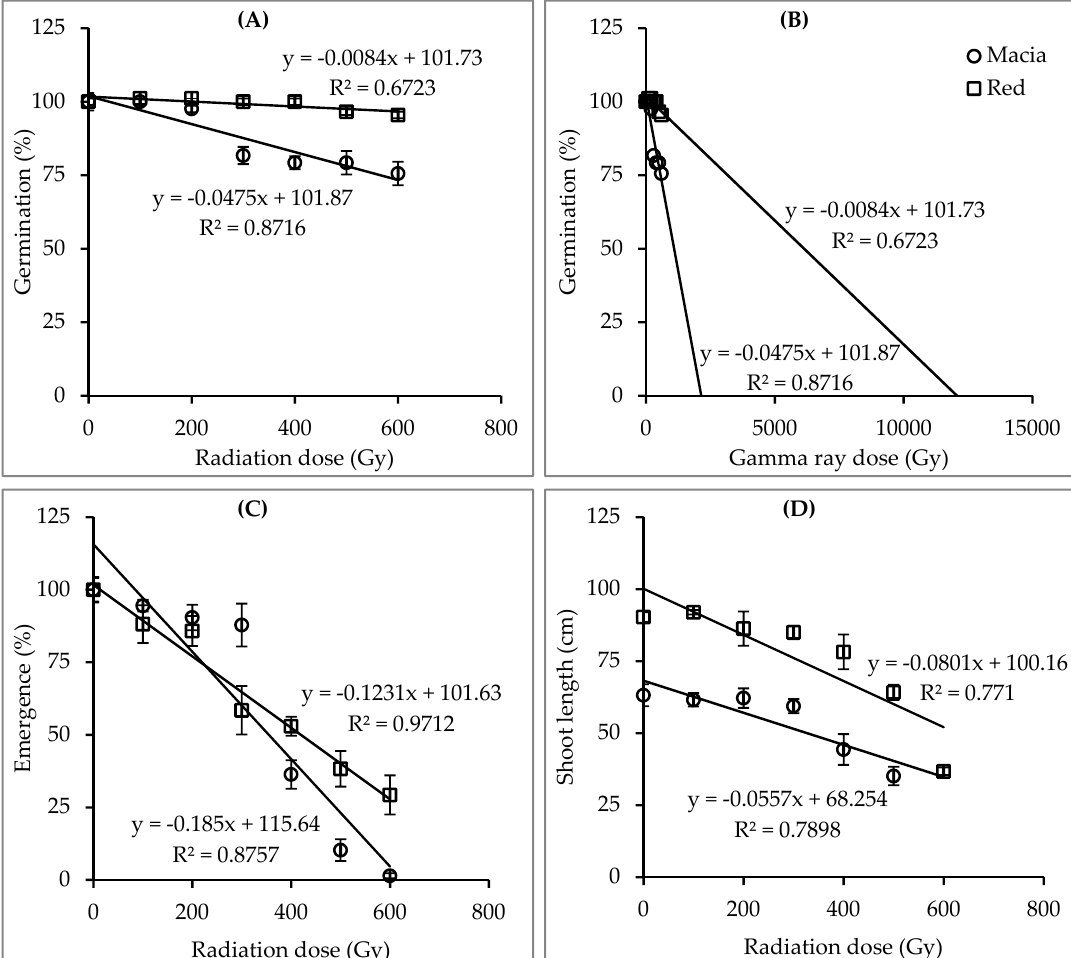
Figure 4. Actual ( A ) and extrapolated ( B ) germination percentage, seedling emergence percentage ( C ), and shoot length ( D ), fitted with straight lines to estimate the LD 50 s of two sorghum genotypes treated with seven gamma radiation doses in experiment II (bars represent standard error). Note: PM = Parbhani Moti, PS = Parbhani Shakti, ICSV = ICSV 15013 and MA = Macia